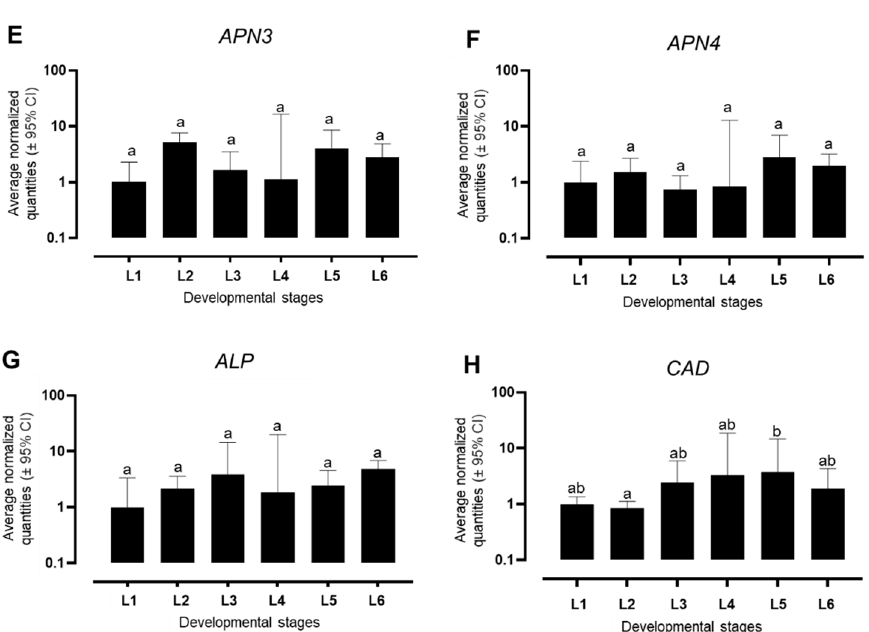
Figure 2. RT-qPCR expression analysis of genes possibly involved in Bt toxicity, analyzed by geNorm across different larval stages of Chrysodeixis includens . Average normalized quantities of ( A ) ABCC2, ( B ) ABCC3 , ( C ) APN1 , ( D ) APN2 , ( E ) APN3 , ( F ) APN4 , ( G ) ALP , and ( H ) CAD . CAD: cadherin; ABCC2/ABCC3: ATP-binding cassette subfamily C2/C3 trans- porter; ALP: alkaline phosphatase; APN: amino peptidase class 1, 2, 3, and 4. Different letters denote a significant differ- ence (One-way ANOVA; post hoc Tukey comparison, p < 0.05).